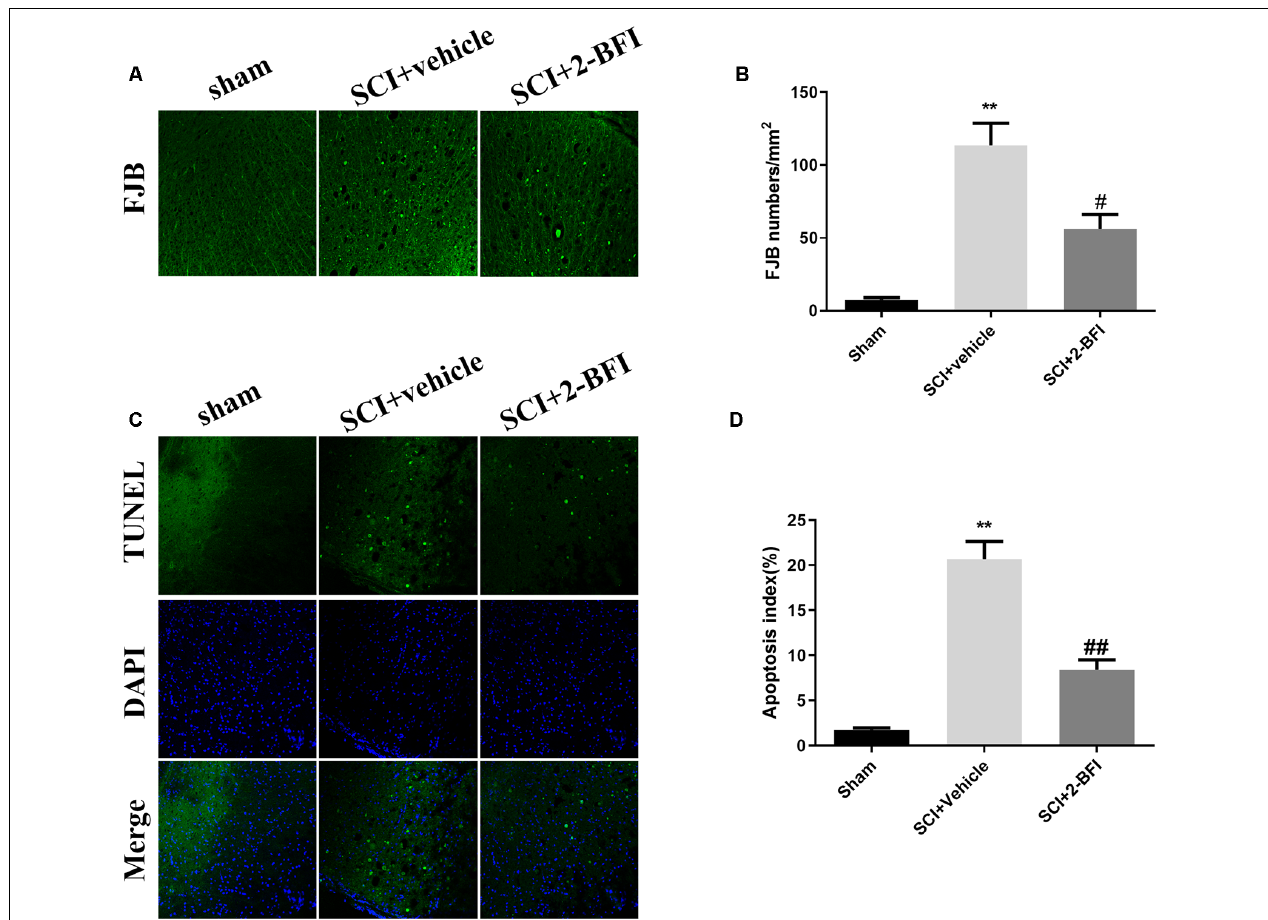
FIGURE 7 | Evaluation of neuronal death at day 3 after operation. Neuronal death was examined by FJB staining (A) . FJB-positive (green) cells per mm 2 were quantified accordingly (B) . Neuronal apoptosis was examined by TUNEL staining (C) . TUNEL-positive (green) cells per mm 2 were quantified accordingly (D) . Scale bars are 10 µ m. The number of positive cells was determined using ImageJ software. n = 6 animals per group. Columns represent the mean ± SD. ∗∗ P < 0.01 vs. the sham group; ## P < 0.01 vs. the SCI+vehicle group; # P < 0.05 vs. the SCI+vehicle